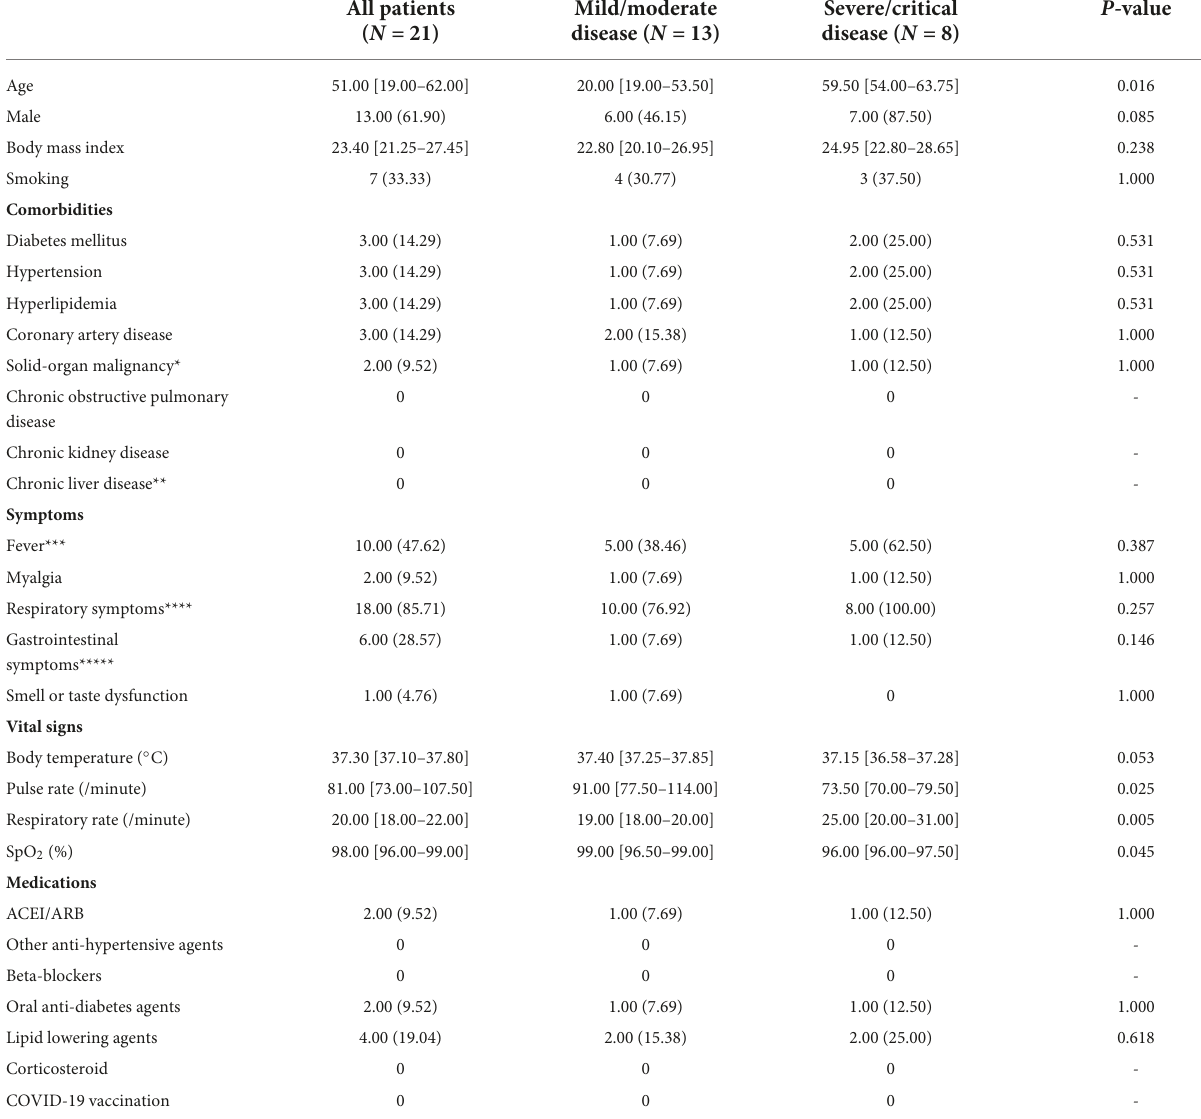
TABLE 1 Demographics and baseline characteristics of